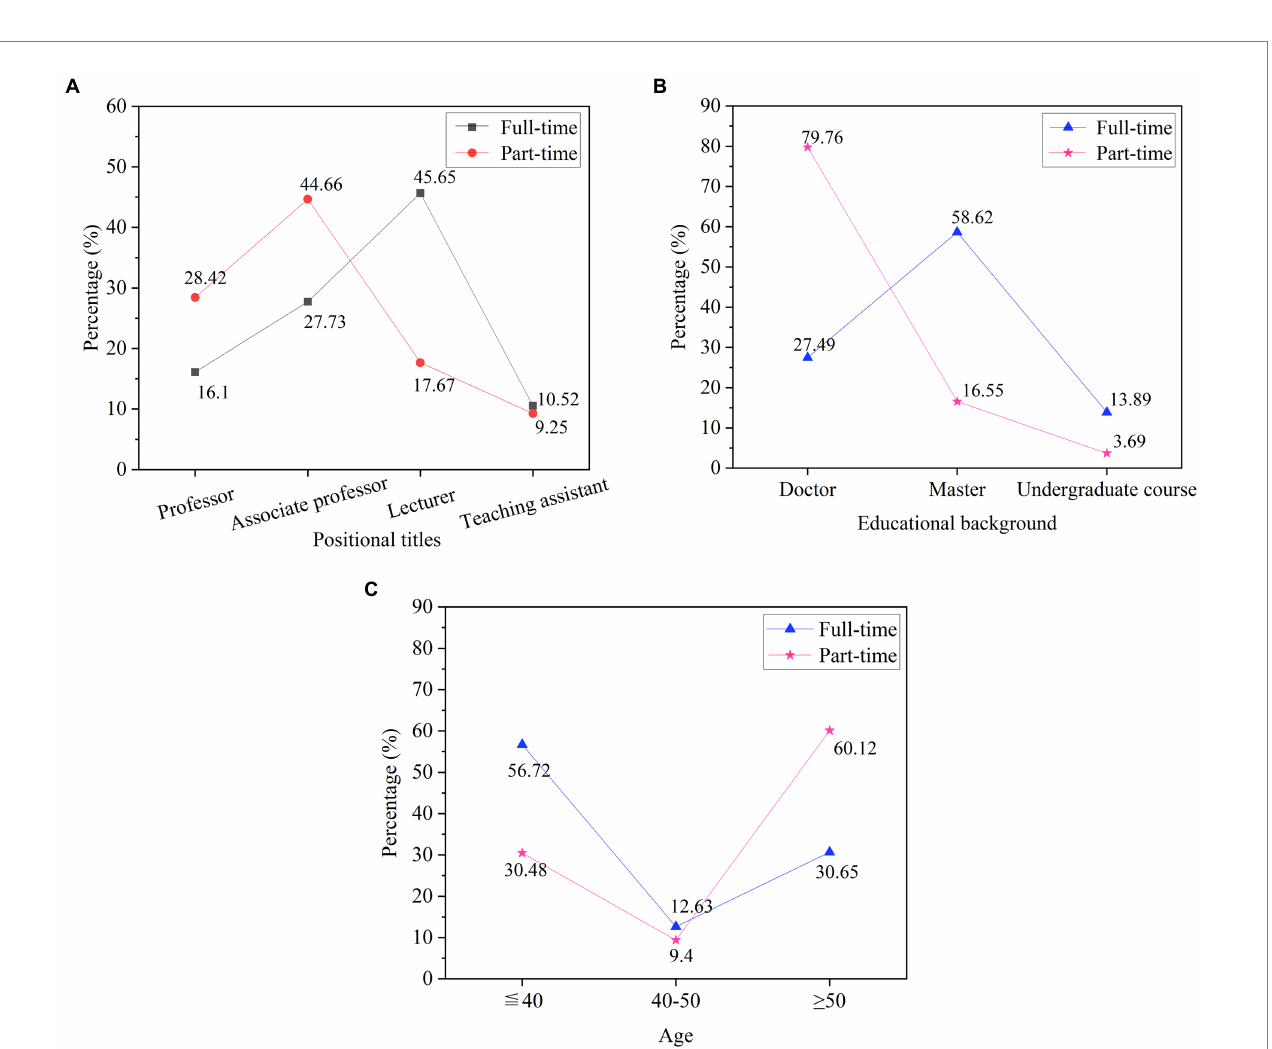
FIGURE 6 Current status of teaching faculty. (A) the professional titles; (B) the academic qualifications; (C) the